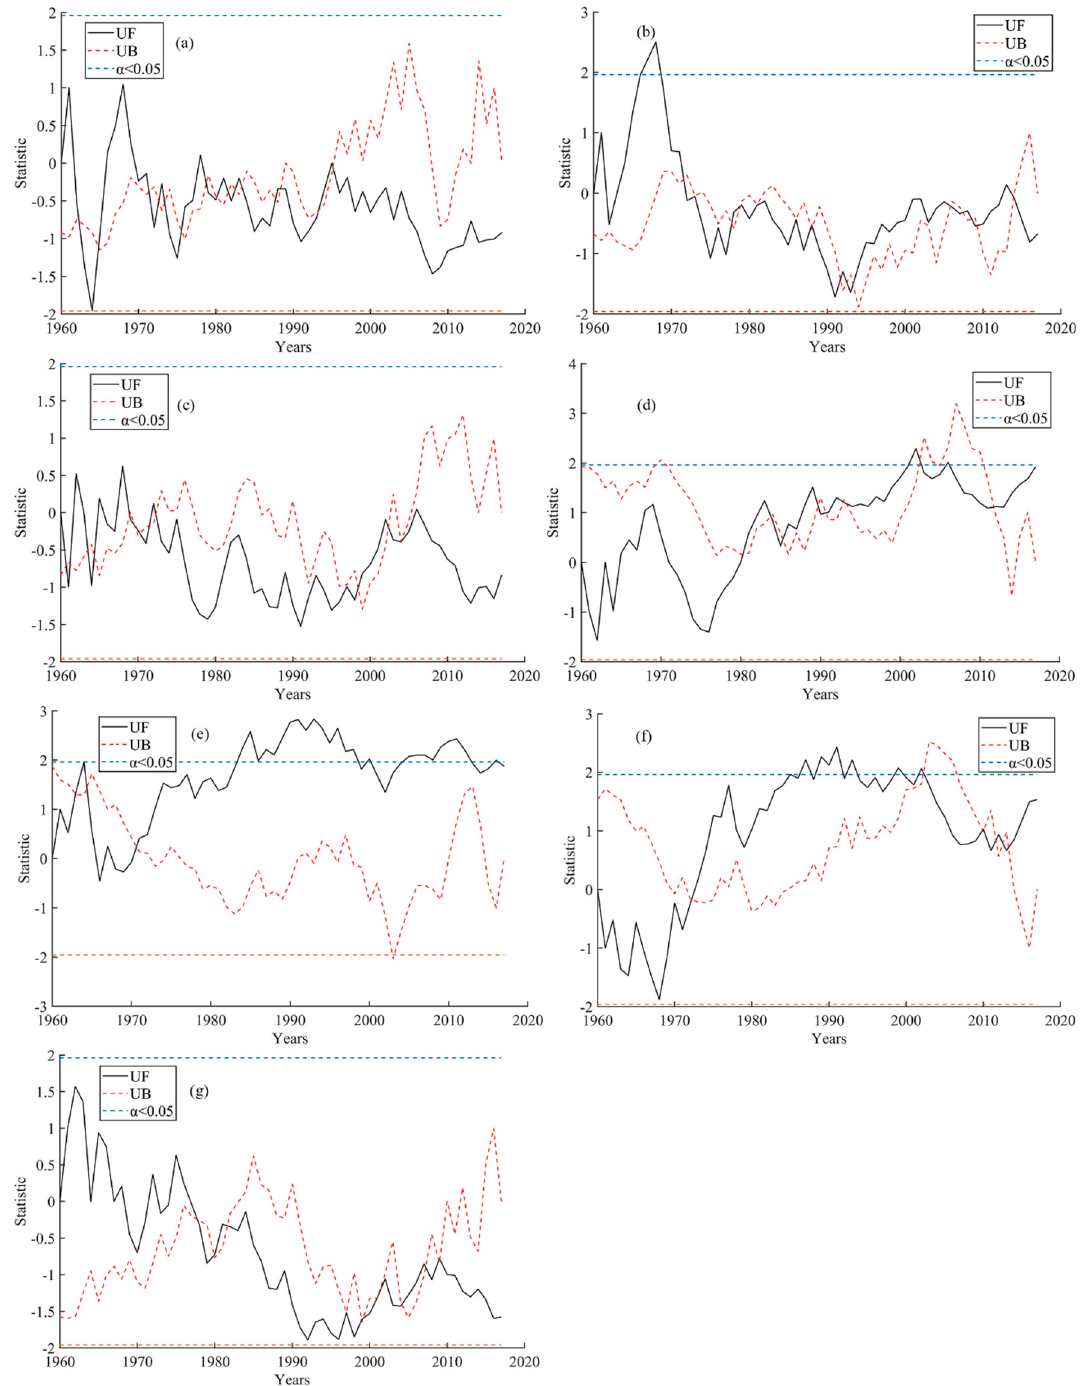
Figure 4. The variation trend of time coefficients of different spatial modes in the North China Plain; ( a – g ) respectively show the results of the Mann-Kendall test for the time coefficients of model 1 to mod-el 7. UF refers to a sequence of statistics calculated in chronological sequence. UB refers to a sequence of statistics calculated in reverse chronological